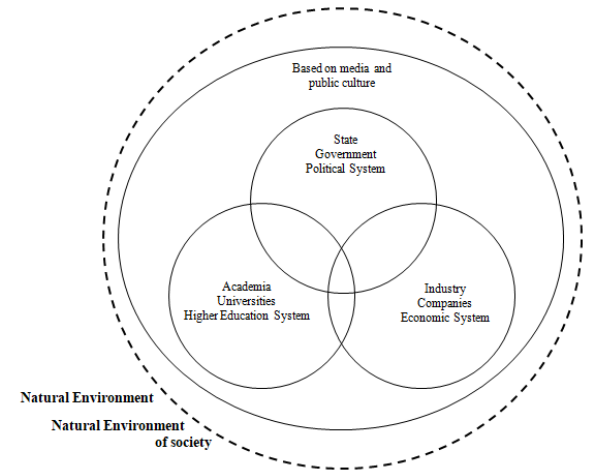
Figure 4. Quintuple helix innovation model (source: created by authors with a base on Etzkowitz & Leydesdorff (2000), Carayannis & Campbell